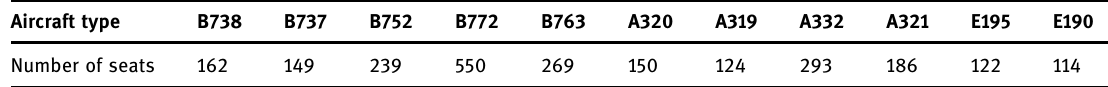
Table 1: Seats numbers in aircraft types in the fl ight schedule Aircraft type